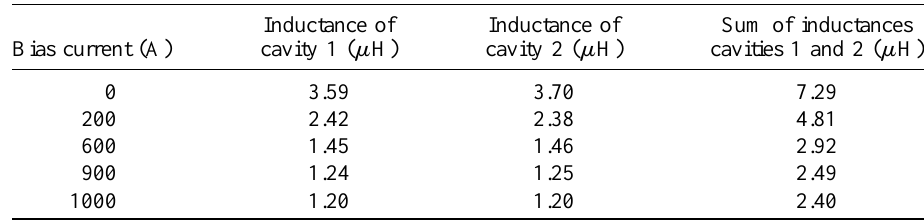
TABLE II. Measured low-frequency